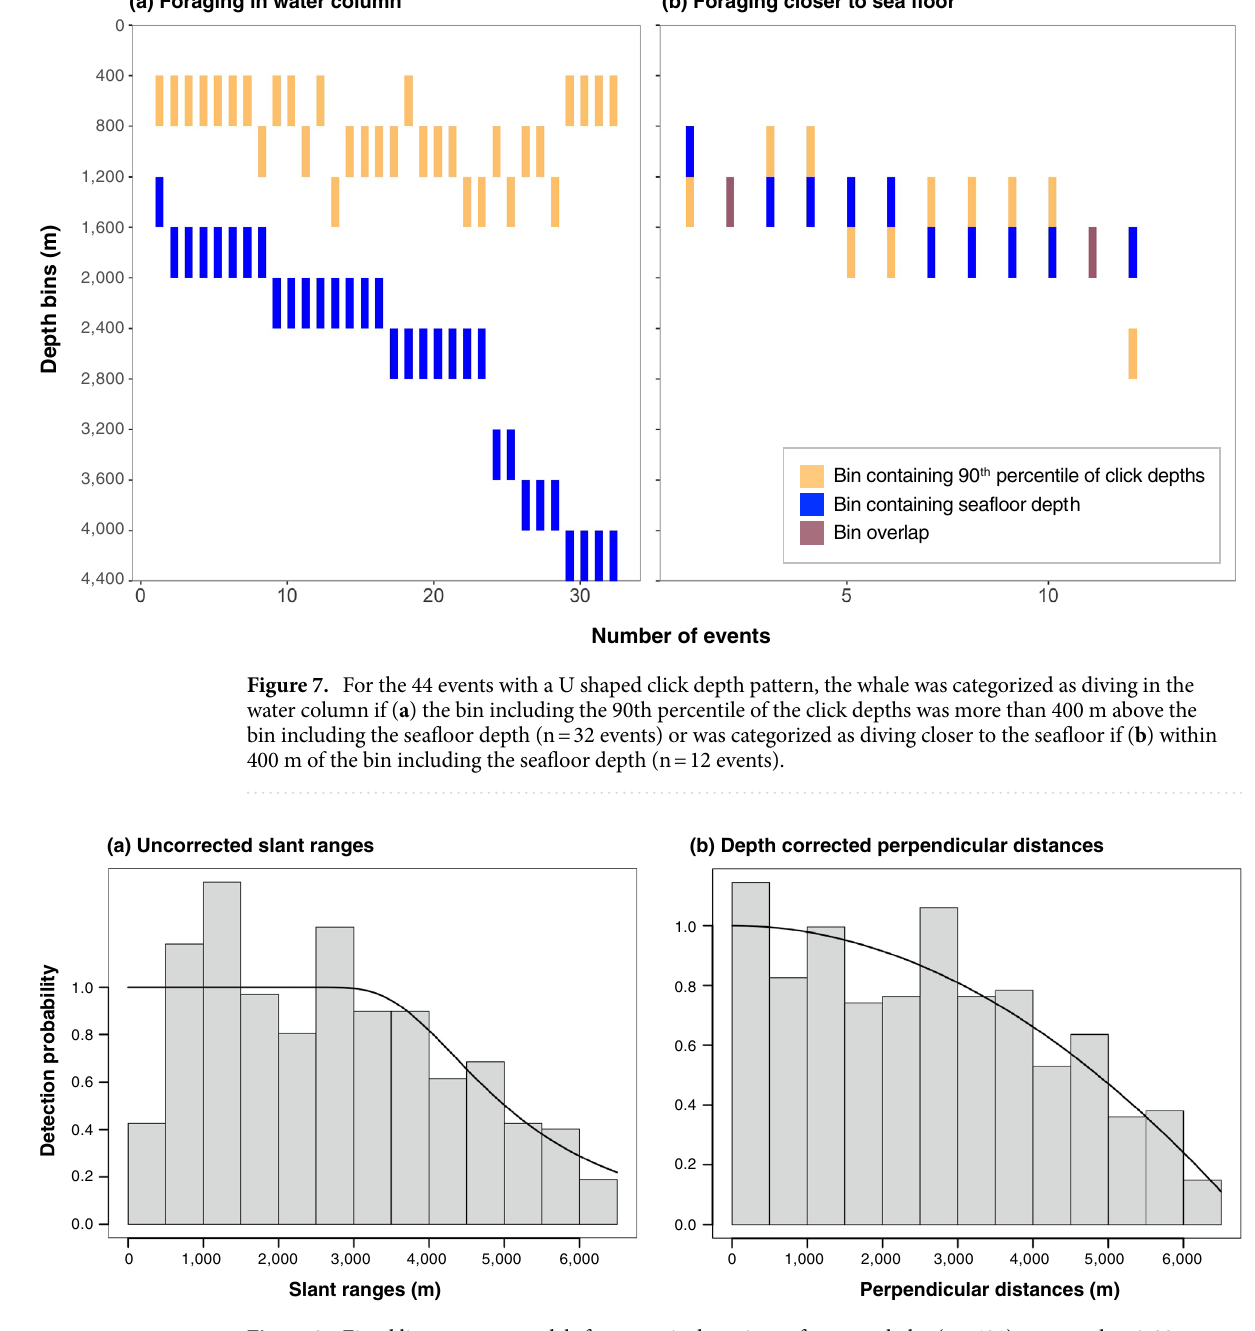
(CV = 3.6%) and an ESW of 5099 m (SE = 182 m). The half normal model using depth-corrected perpendicular